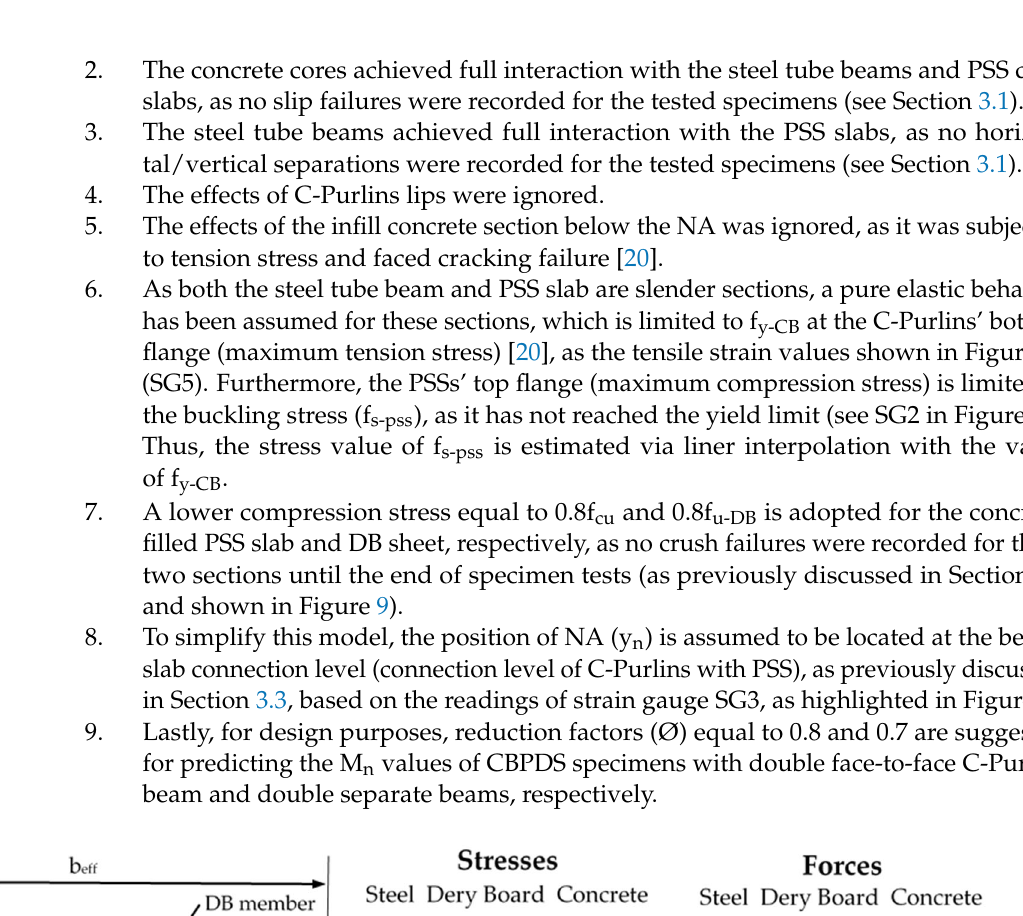
Figure 18. Compare the nominal bending (ØM n ) values with the experimental results (M u ).